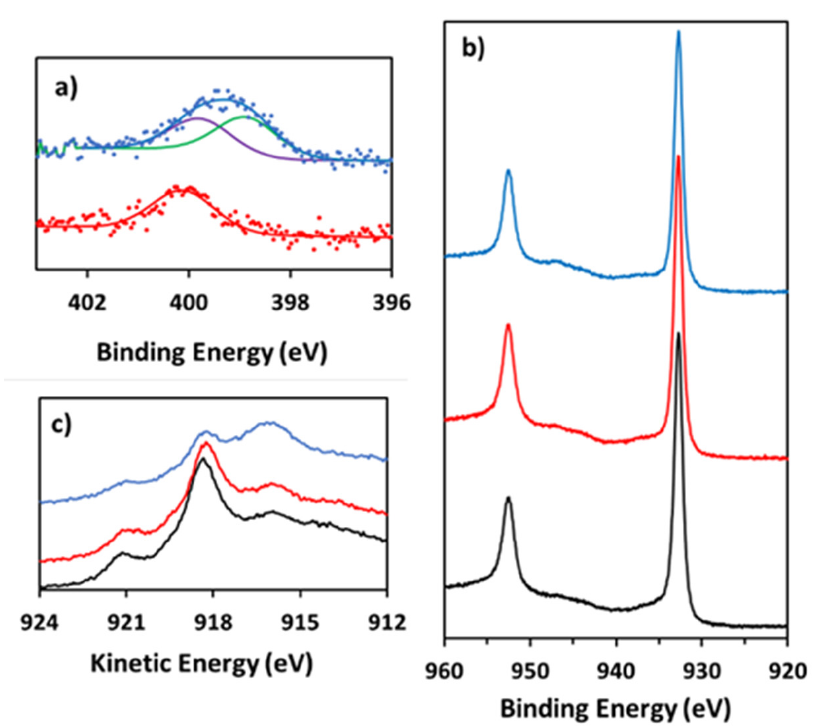
Figure 6. XPS spectra of the ( a ) nitrogen 1s signal from samples of CF-18H-DCU (top, dotted blue trace) and CF-18H-100U (bottom, dotted red trace), with fittings in solid lines, ( b ) copper 2p signal from CF-18H (bottom, black), CF-18H-100U (middle, red) and CF-18H-DCU urea (top, blue) and ( c ) copper Auger LMM peak from samples of CF-18H (bottom, black), CF-18H-100U (middle, red) and CF-18H-DCU (top, blue).